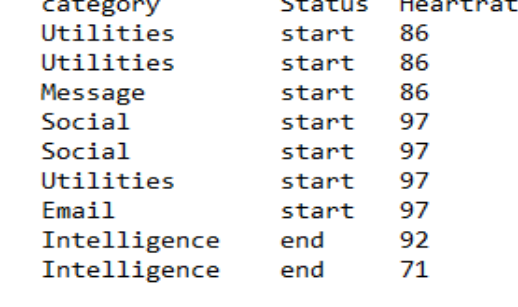
Figure 12. An Example of Event Log.